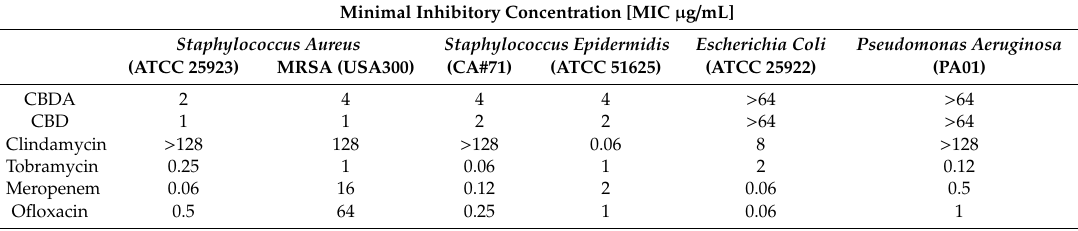
Table 1. Minimal inhibitory concentration of CBDA and CBD along with key antibiotics towards a panel of Gram-positive and Gram-negative species. CBDA is slightly less potent than CBD against Gram-positive strains, while both are inactive against Gram-negatives